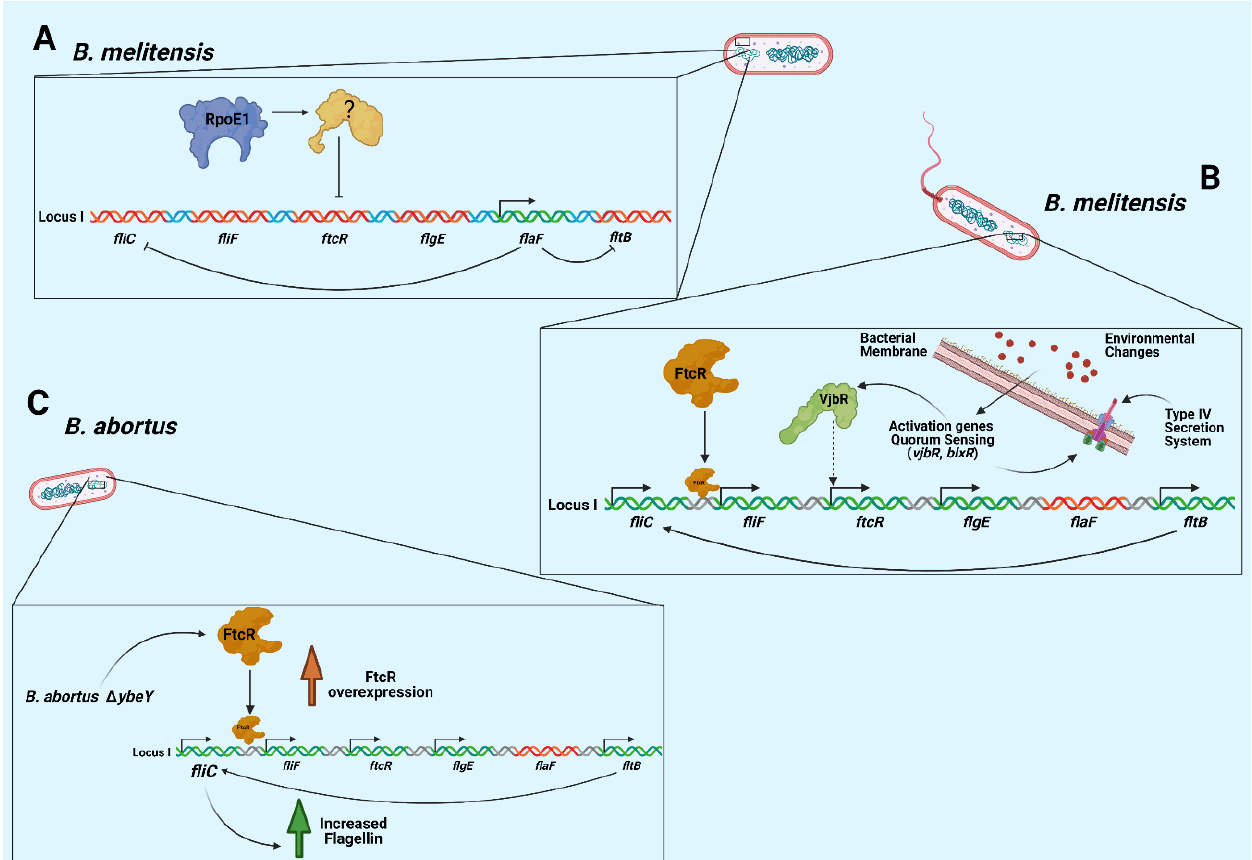
Figure 2. Transcriptional regulation of some of the flagellar genes described in Brucella at locus I. ( A ) Repression of flagellar expression in B. melitensis is linked by the repressor RpoE1 (and other